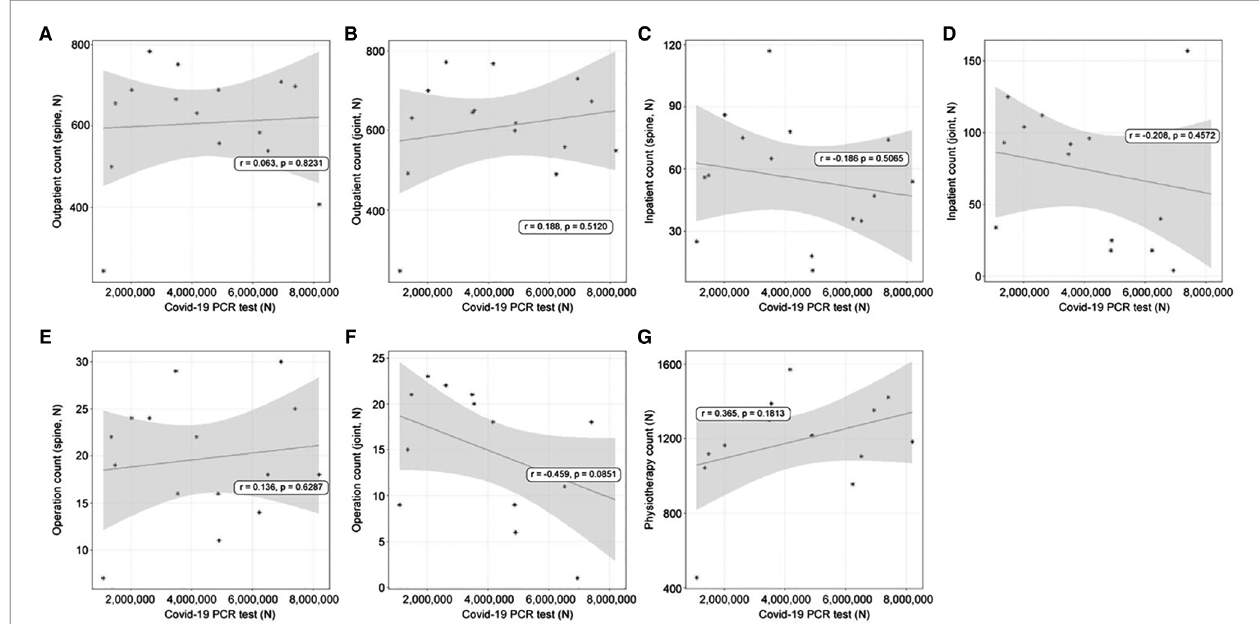
FIGURE 2 | The linear relationships between coronavirus disease 2019 (COVID-19) polymerase chain reaction (PCR) test count and orthopedic hospital visiting patterns. ( A ) Spine department outpatient count; ( B ) Joint department outpatient count; ( C) Spine department inpatient count; ( D ) Joint department inpatient count; ( E ) Spine operation patient count; ( F ) Joint operation patient count; ( G ) Physiotherapy patient count.